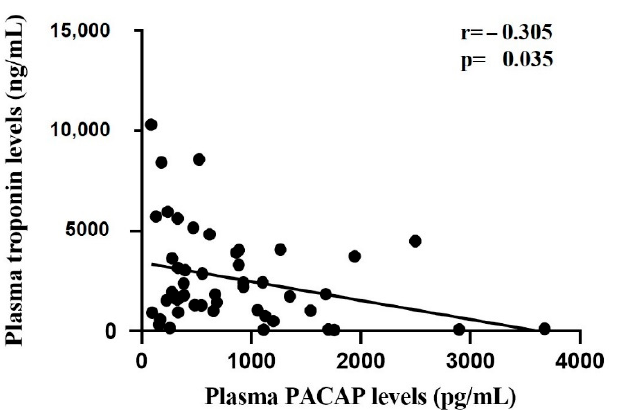
Figure 6. Correlation between PACAP and troponin levels in STEMI patients.